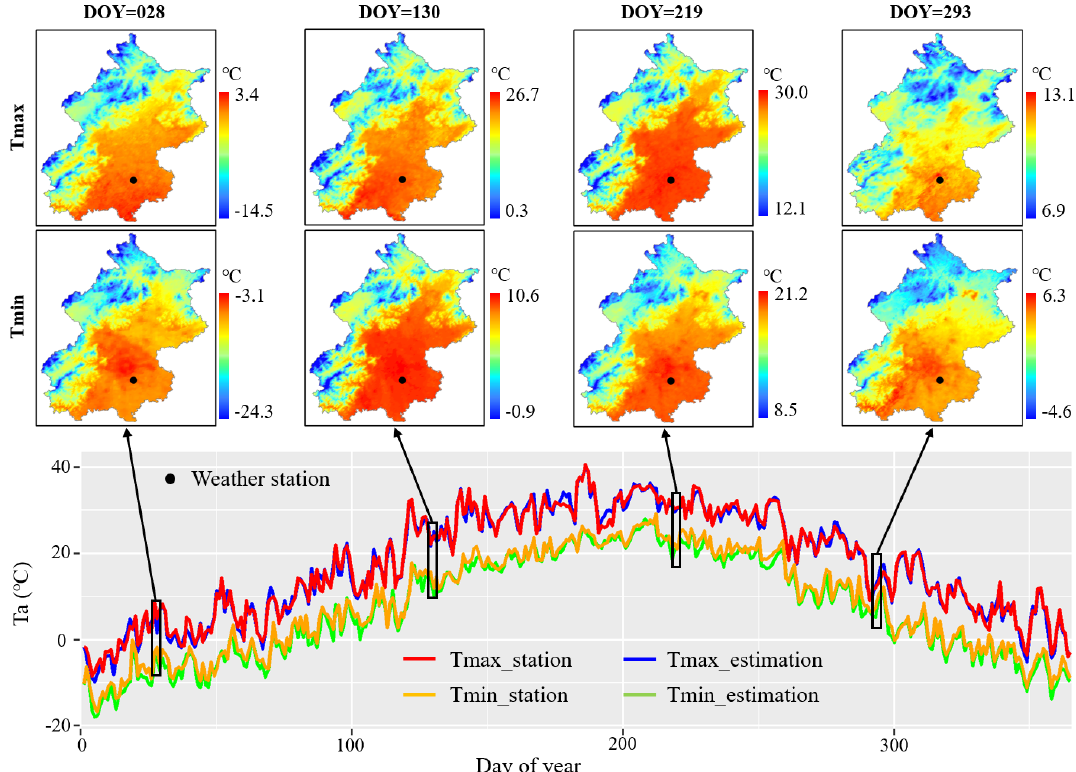
Figure 8. Temporal pattern of estimated and observed T a at the weather station of Beijing (black point) in the year 2010. The black rectangles are example days showing maps of estimated data in